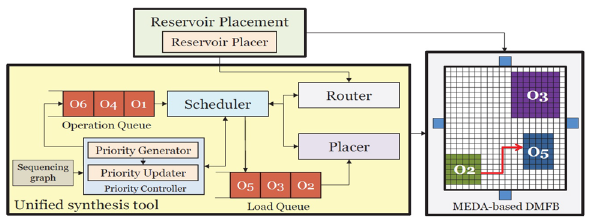
Fig. 1 Synthesis flow for MEDA-based biochips [25]